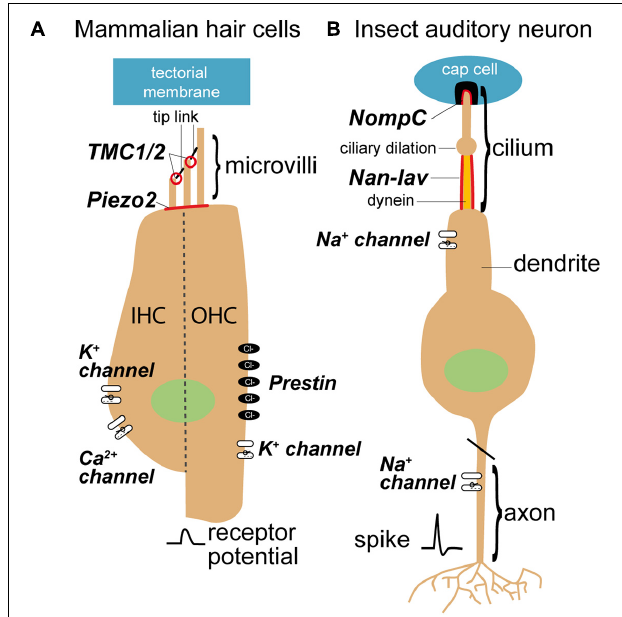
FIGURE 4 | Sensory cells in mammals (A) and insects (B) and mechanosensitive channels that are involved in the transduction process. Mechanosensitive channels in mammals belong to the transmembrane channel-like proteins (TMCs), whereas mechanosensitive channels in the insect ears are members of the transient receptor potential (TRP) family (see for review Jin et al., 2020). TMC are believed to evolved from TRP channels (Saier, 2016). Nan-Iav, nanchung-inactive; NompC, no mechanoreceptor potential